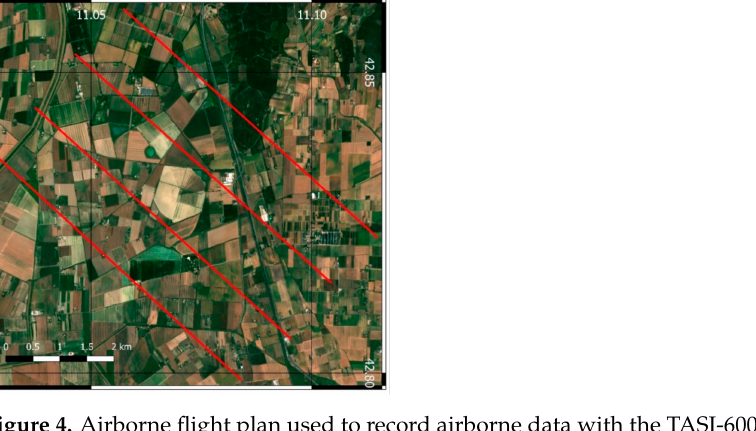
Figure 4. Airborne flight plan used to record airborne data with the TASI-600 and HyPlant DUAL sensor. Airborne raw data were recorded during the 2018 Surfsense campaign [51]. The basemap was elaborated from Sentinel-2A data acquired on 8 July